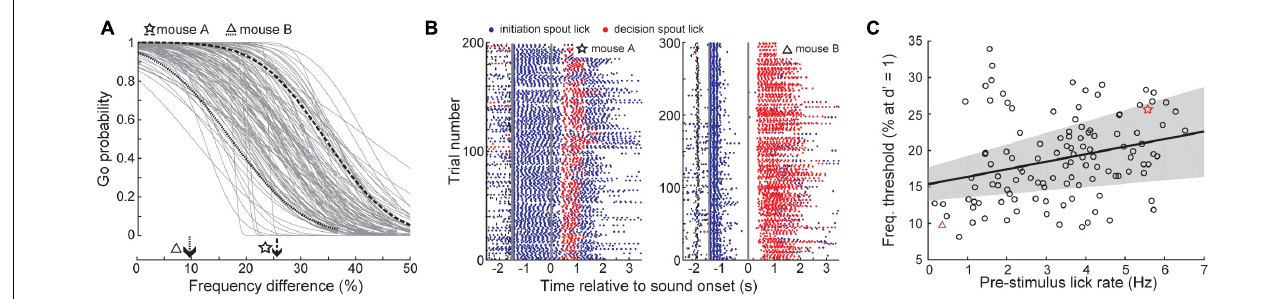
FIGURE 7 | Vigorous licking during the foreperiod is associated with impaired frequency discrimination. (A) Psychometric functions for self-initiated frequency recognition trials across all behavioral sessions. (B) Lick rasters for the two example sessions shown in panel (A) . Blue and red dots denote lick timing on the initiation and decision spouts, respectively. Thick gray vertical lines indicate the timing of trial initiation and sound onset. Small vertical black lines indicate the timing of visual ready cue. (C) Frequency thresholds are improved in sessions with minimal licking prior to tone onset. Thick black line and gray shading represent the linear regression line and the bootstrapped 95% confidence interval of the linear regression, respectively. Each individual test session is represented by a dot, red symbols indicate example behavior sessions shown in panels (A,B)